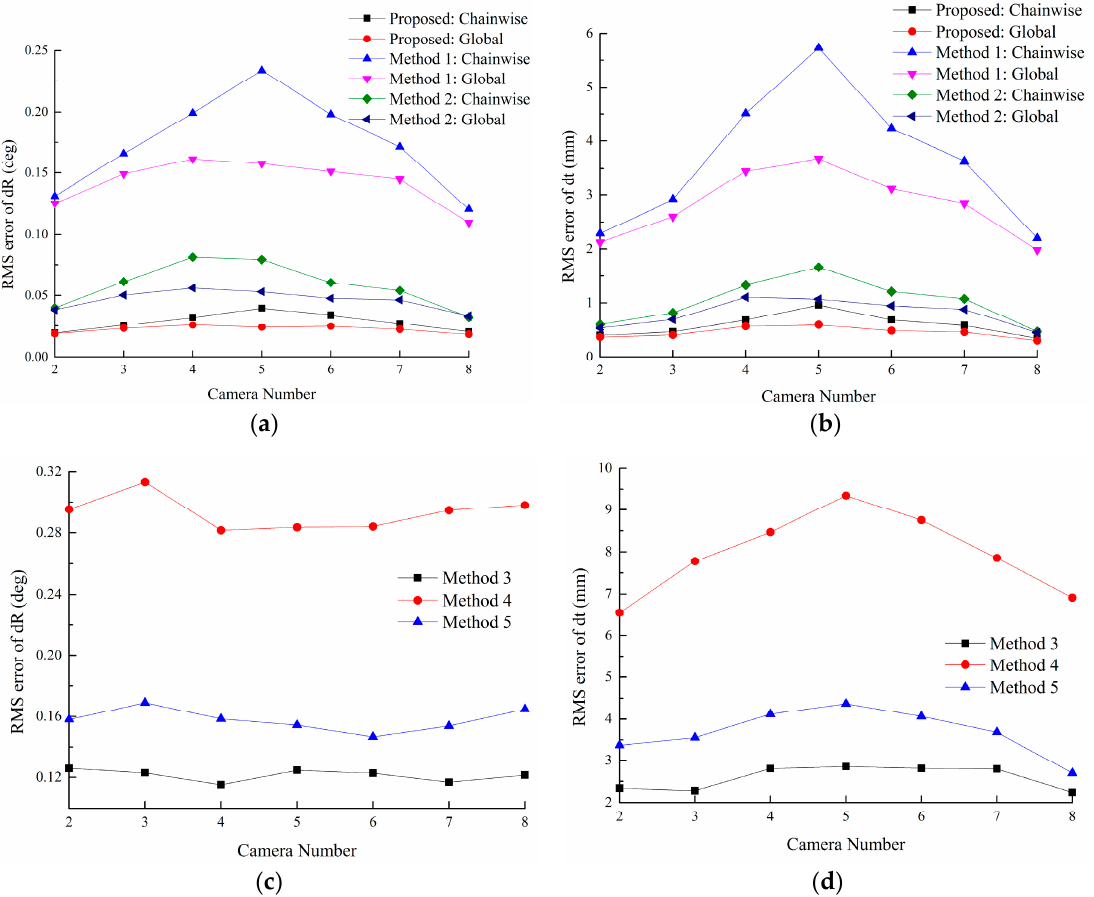
Figure 7. Calibration error of each method. ( a , b ) RMS errors of rotation vector and translation vector of the proposed method, Method 1 and 2; ( c , d ) RMS errors of rotation vector and translation vector of Methods 3 – 5.